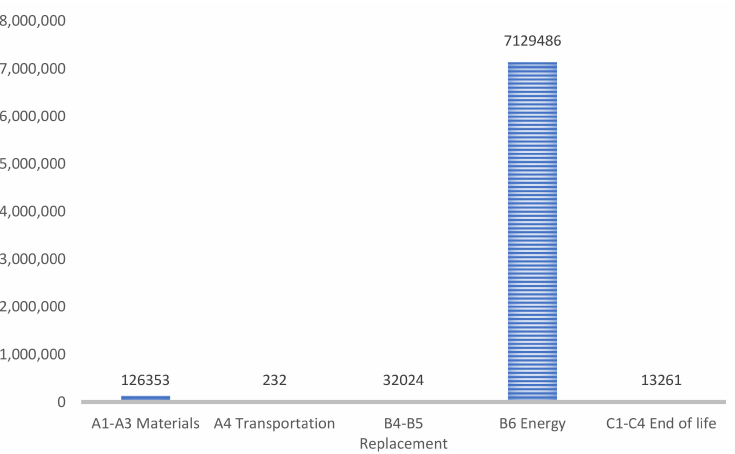
Figure 8. Scenario B: Global warming kg CO2, calculated considering the amount of operational